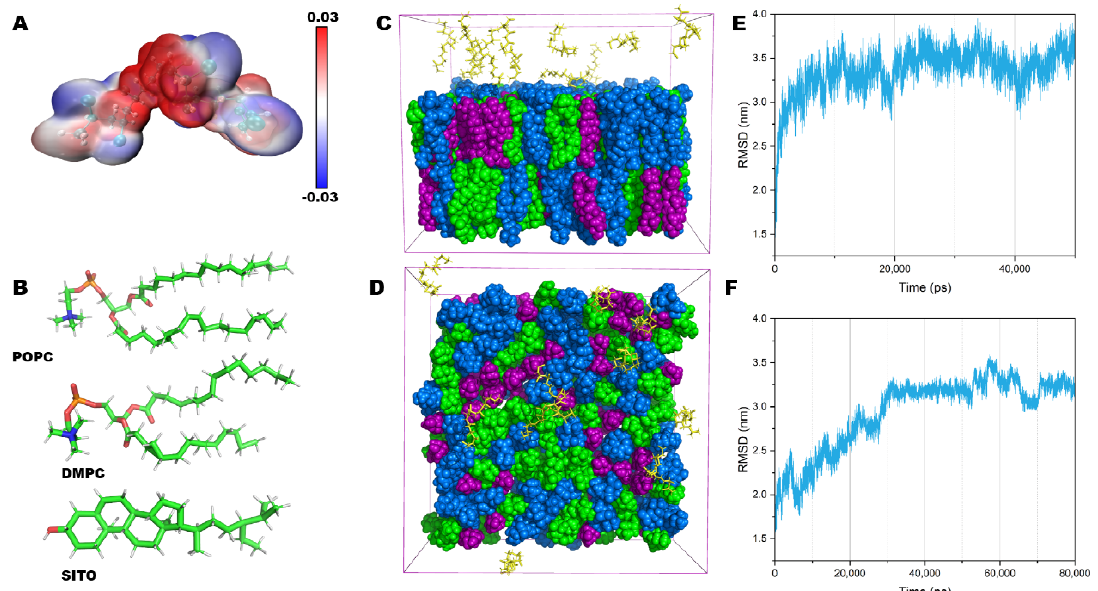
Figure 2. All-atom molecular models of PVC nanoparticles and the lipid membrane complex used in the MD simulations. ( A ) Chemical structure and electrostatic potential of the PVC10 monomer. The color scale bar is shown with the corresponding ESP values (a. u.) ( B ) Structures of the POPC, DMPC, and SITO lipid molecules in the model membrane. POPC (1-palmitoyl-2-oleoyl-sn-glycero- 3-phosphocholine), DMPC (1,2-dimyristoyl-sn-glycero-3-phosphocholine), and SITO (sitosterol). ( C , D ) Lateral view ( C ) and top view ( D ) of a typical configuration of PVC10 monomers and a mixed lipid bilayer in a water box are shown in green, blue, and purple, respectively, and the PVC10 monomers are shown in orange. ( E , F ) Root mean square deviation (RMSD) plots for the simulation system in the absence ( E ) and presence ( F ) of PVC10